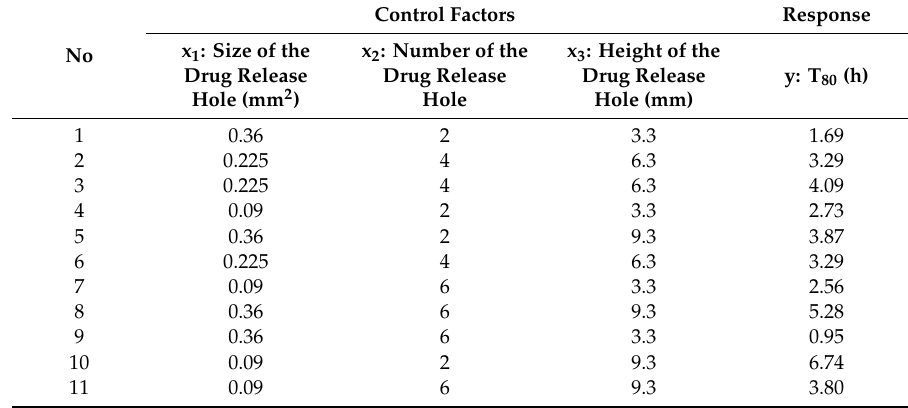
Figure 3. In vitro dissolution profiles of the gastroretentive sustained release drug delivery systems in a factorial design batch. Table 1. Two-level factorial design with three control factors and the experimentally determined response (T 80 ).